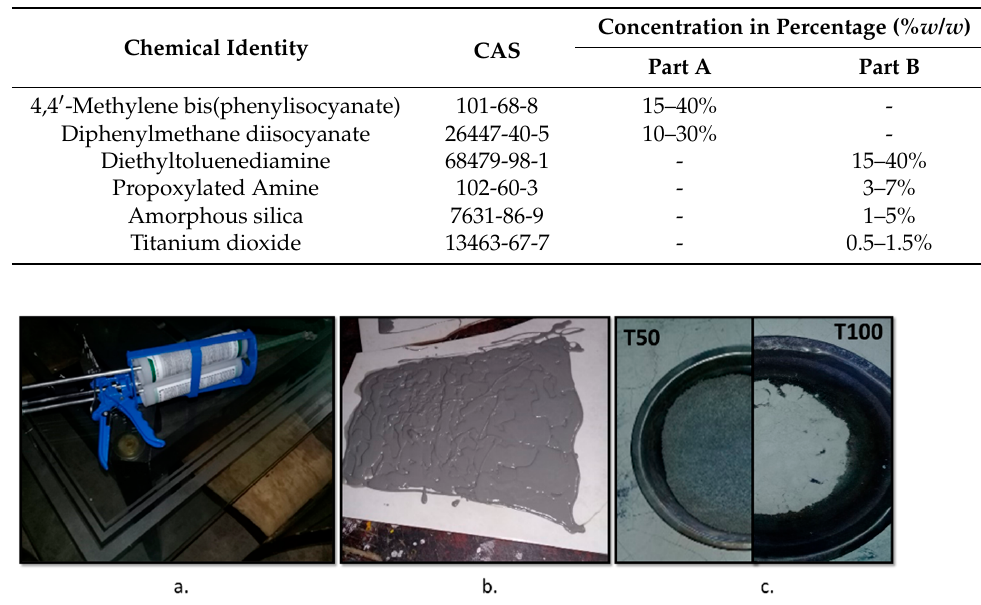
Table 1. Chemical composition of the PU used [18].